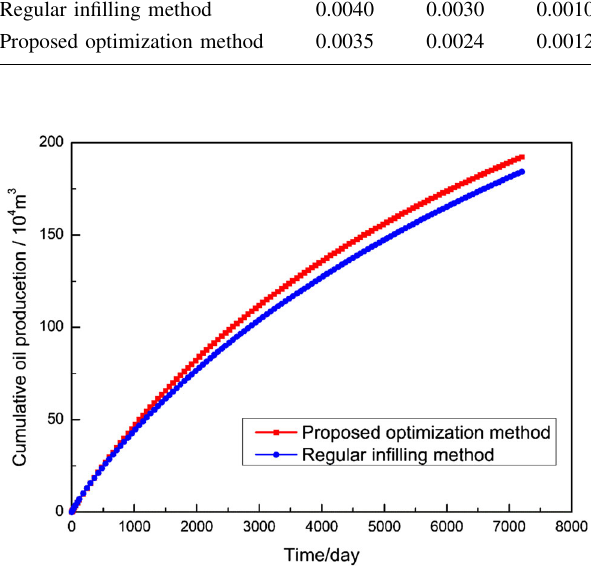
Fig. 8 Cumulative oil production comparison curve of different infilling